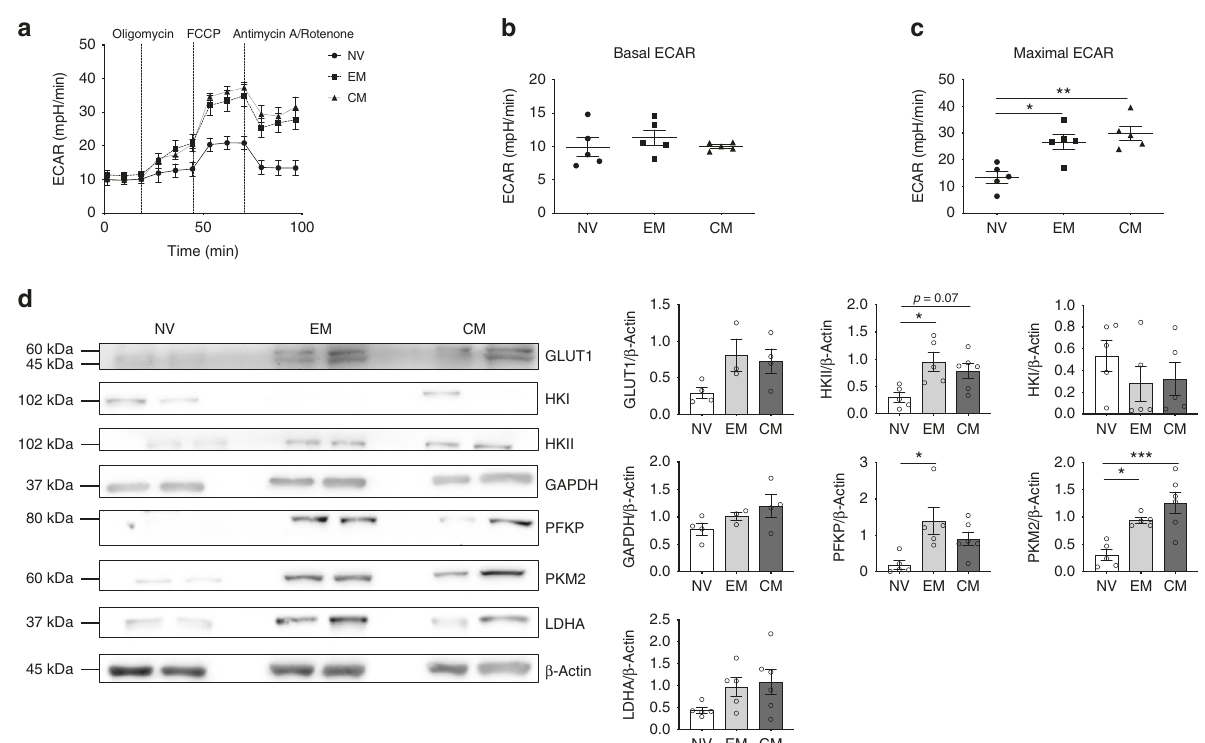
Fig. 1 Quiescent EM and CM T-cells are metabolically active. a Glycolytic stress pro fi le of NV, EM and CM T-cells by measuring ECAR before and following injections of oligomycin (0.75 μ M), FCCP (1 μ M) and antimycin A and rotenone (1 μ M) at the time points indicated. Basal ( b ) and maximal ECAR ( c ) in NV, EM and CM T-cells. d Representative immunoblots from two different donors per cell type for GLUT1, HKI HKII, GAPDH, PFKP, PKM2 and LDHA and β -actin. Respective densitometry normalised to β -actin is shown. Data are either representative of fi ve independent experiments ( a – c ) or 3 − 4 experiments ( d ). Statistical analysis was performed using a non-matching one-way ANOVA with Tukey ’ s multiple comparison test ( b – d ). For non-parametric data, a Kruskal − Wallis test with Dunn ’ s multiple comparisons test was used. Data expressed as mean ± SEM; * p ≤ 0.05, ** p ≤ 0.01, *** p ≤